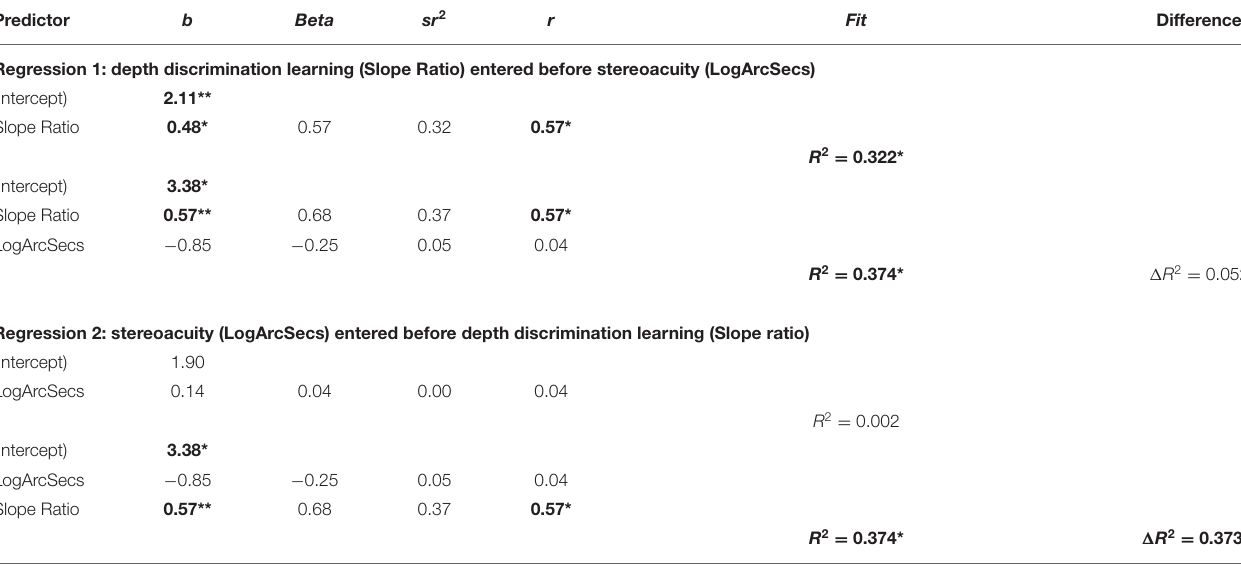
TABLE 2 | Results of a pair of hierarchical regression models predicting performance gains of RT during skill training. Predictor b Beta sr 2 r Fit Difference